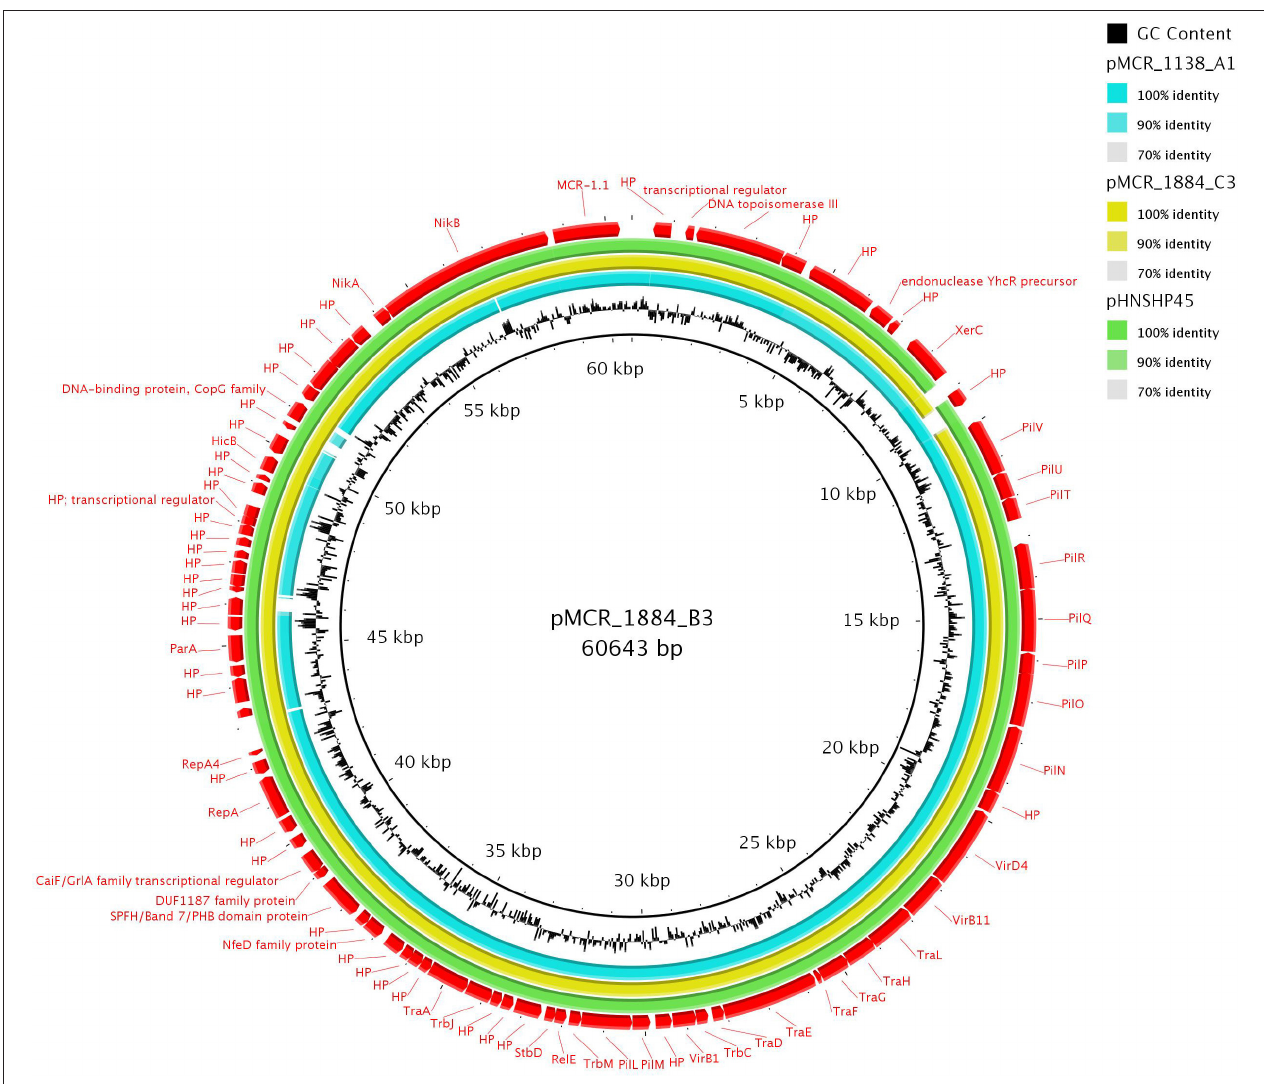
FIGURE 2 | Sequence alignment of two IncI2 and one hybrid IncX4-I2 mcr-1 -encoding plasmids. The plasmid pMCR_1884_B3 (GenBank accession no. MT929283) was used as reference to compare with other plasmids.